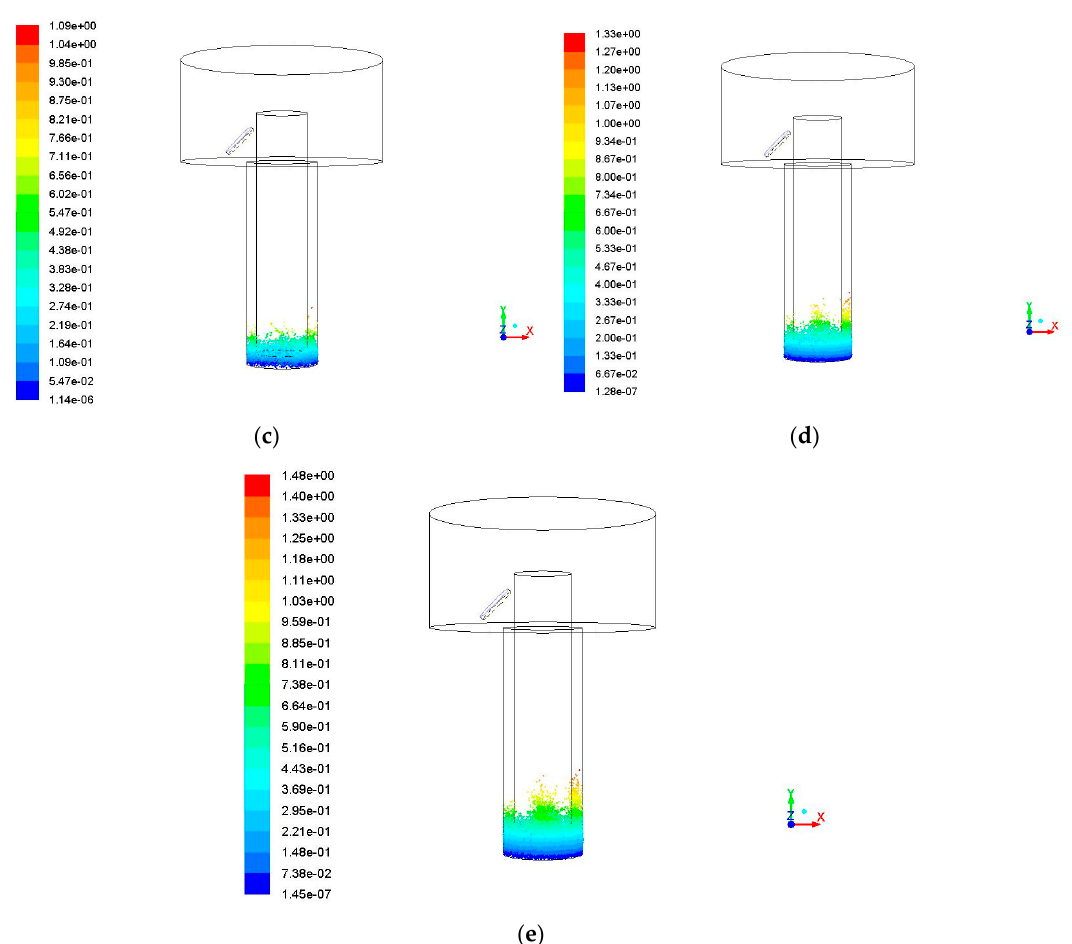
Figure 12. The debris movement with time when the hole depth is 4 mm, amplitude is 5 μ m, frequency is 20 kHz. ( a ) Initial debris distribution; ( b ) Debris distribution at 0.01 s; ( c ) Debris distribution at 0.02 s; ( d ) Debris distribution at 0.03 s; and, ( e ) Debris distribution at 0.04 s.